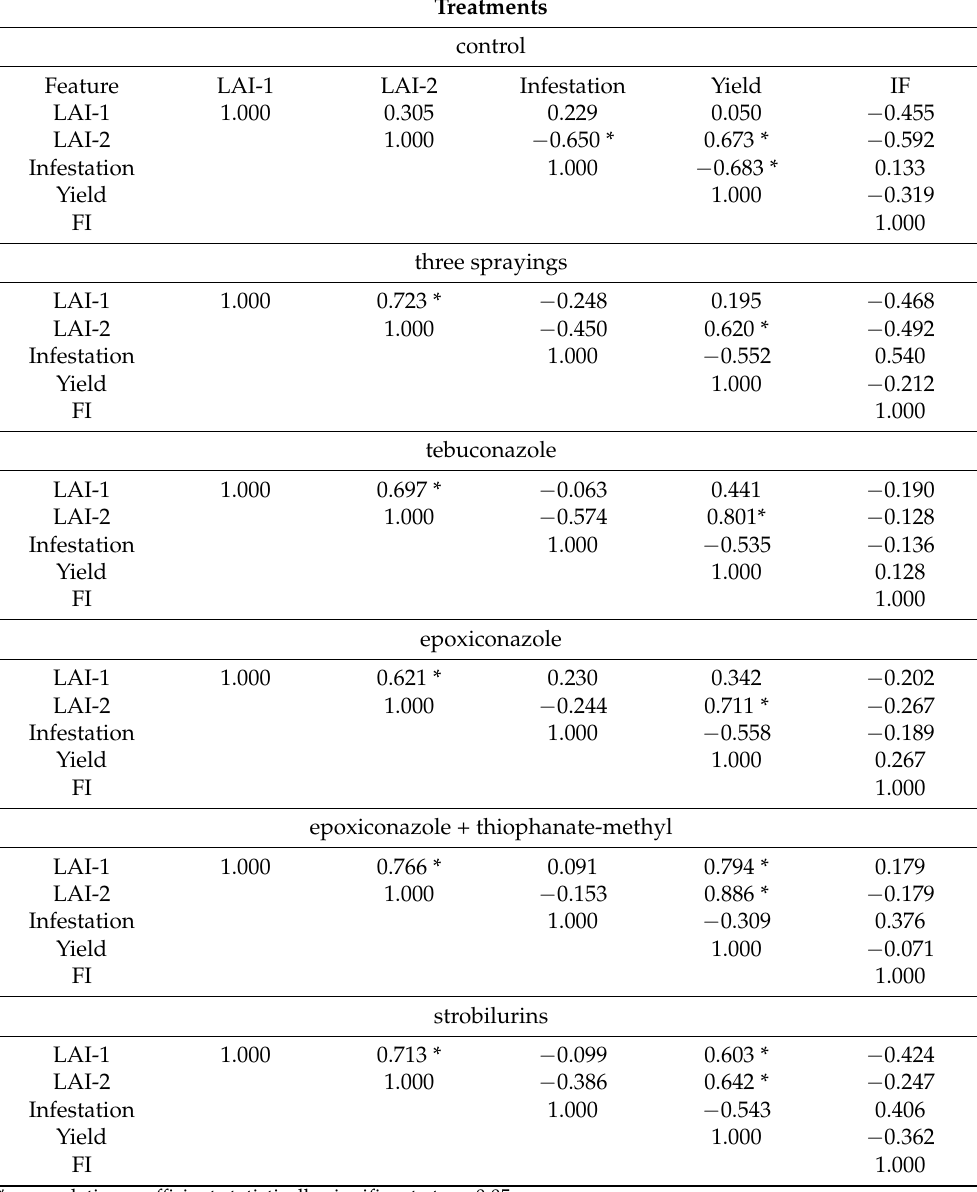
Table 9. Correlation of foliage characteristics of sugar beet averaged for the study years by fungicidal protection